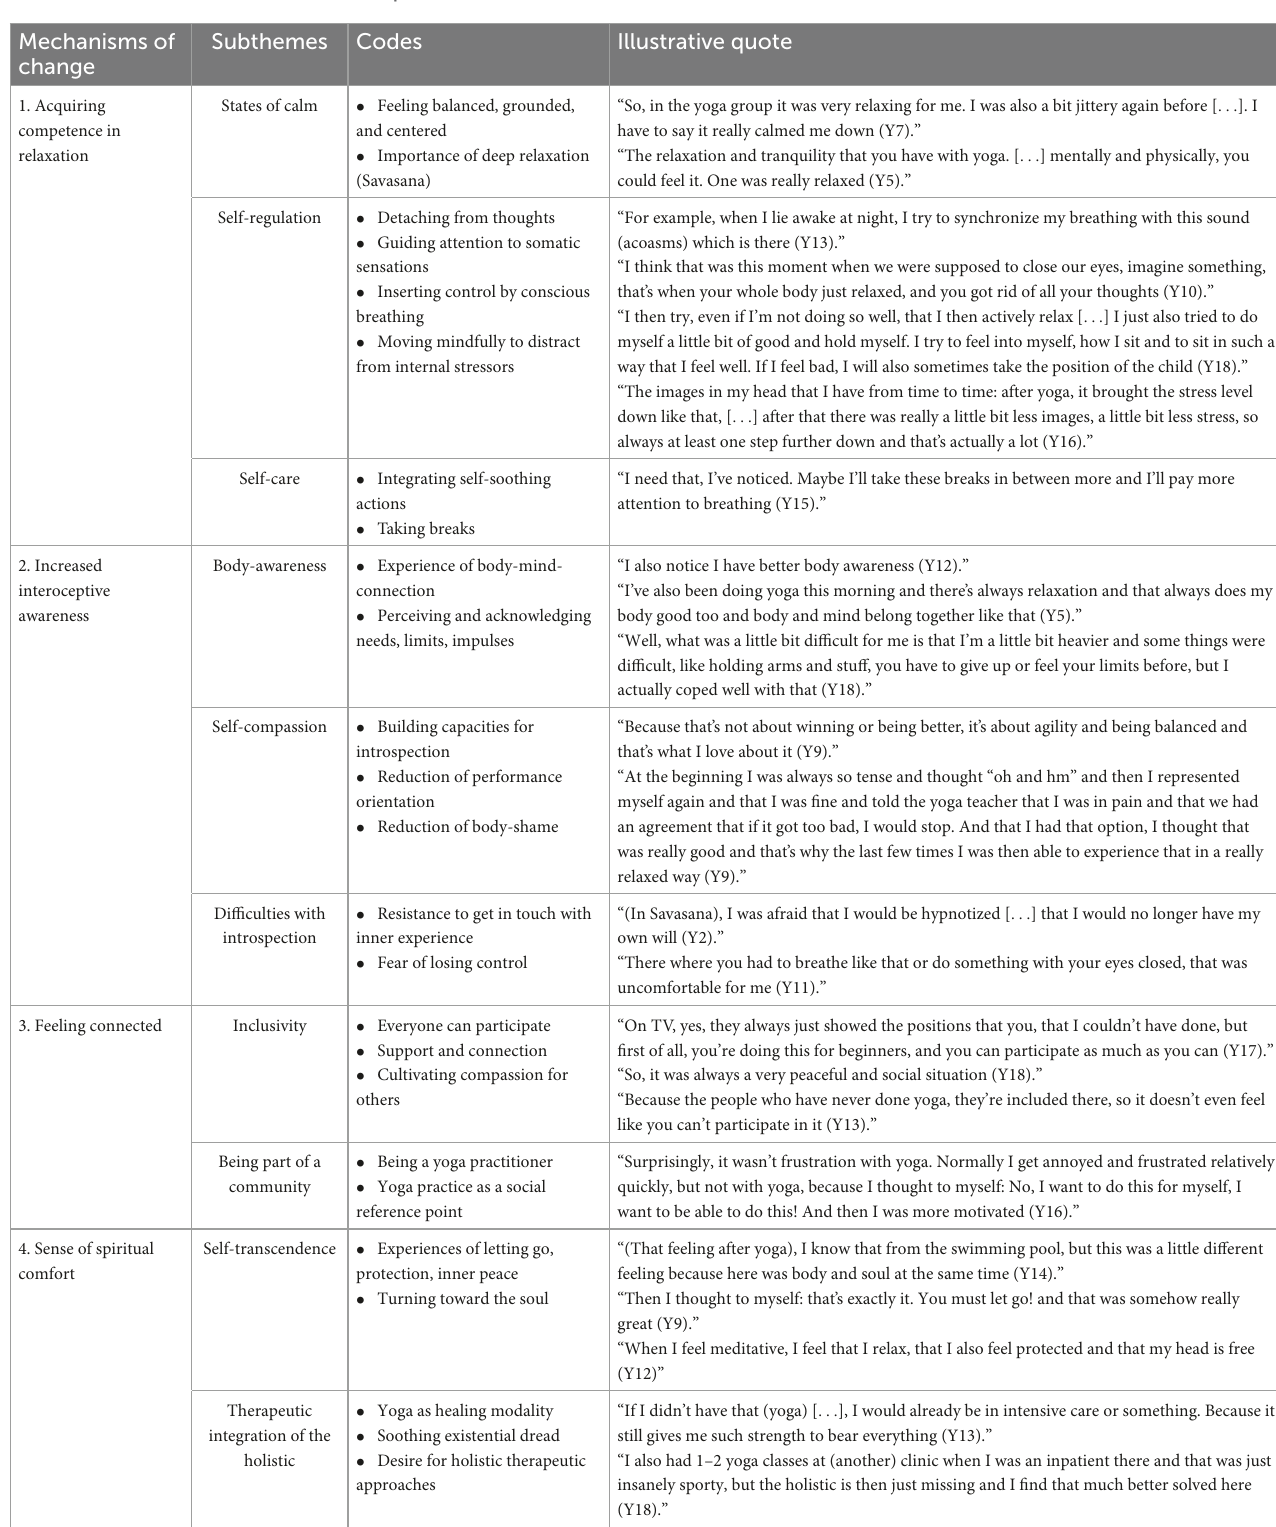
TABLE 4 Mechanisms, subthemes, codes, and